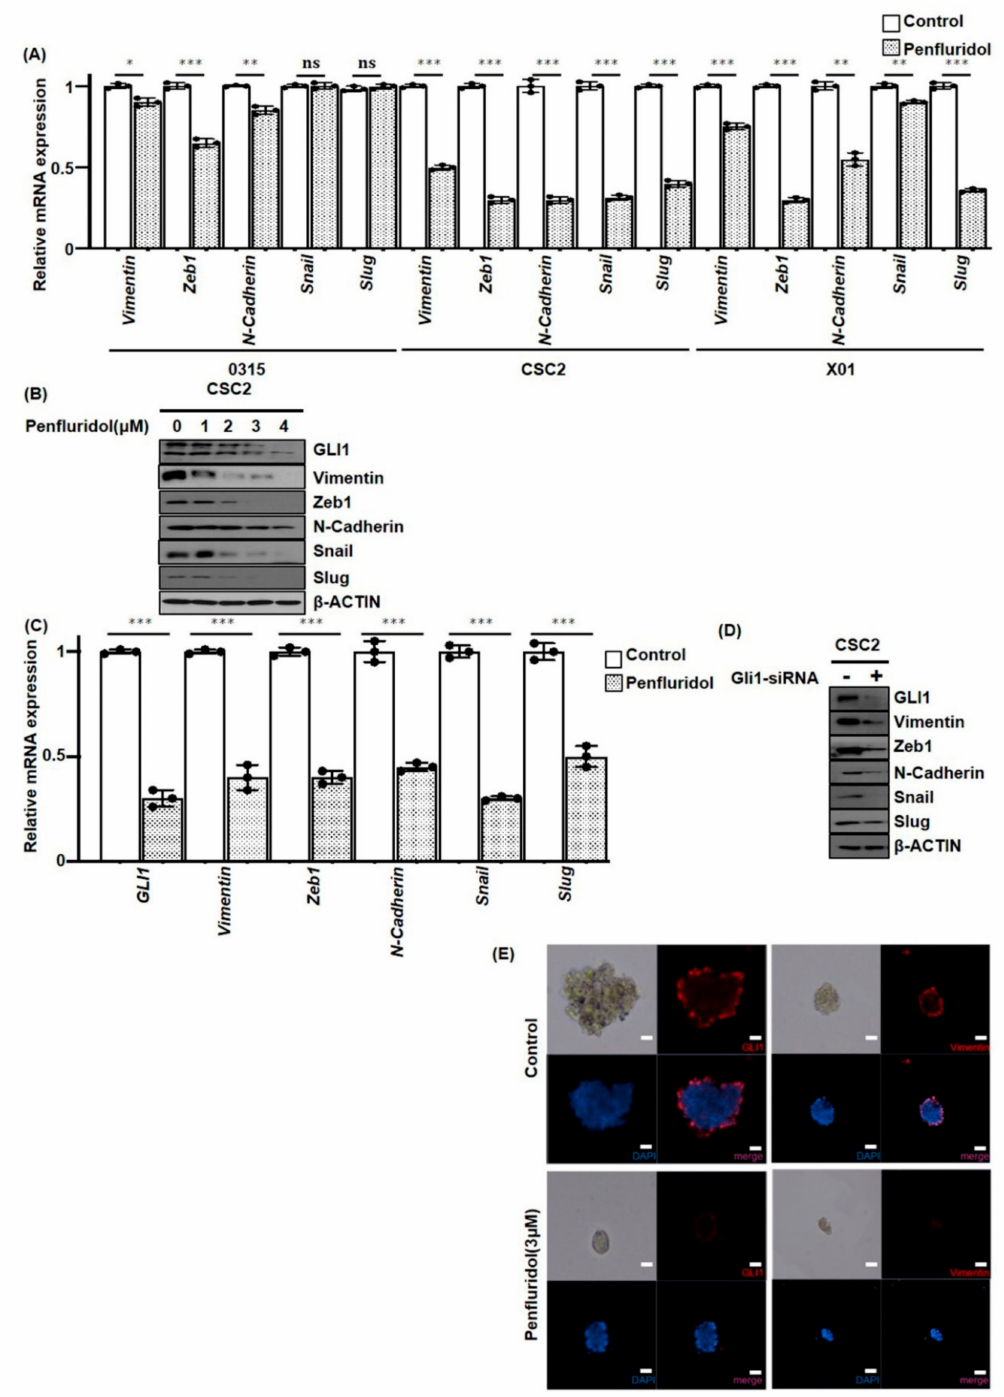
Figure 4. GLI1 inhibition by PFD suppresses EMT factors in GSCs. ( A ) RT-qPCR for vimentin, ZEB1, N-cadherin, Snail, and Slug at 48 h after 2 µ M PFD treatment, and ( B ) Western blotting analyses for GLI1, vimentin, ZEB1, N-cadherin, Snail, and Slug at di ff erent concentrations of PFD. Loading control used was GAPDH or β -actin. Data are presented as the mean ± SD of triplicate qPCR assays (ns, no significance; * p < 0.1, ** p < 0.01, *** p < 0.001, when compared with no treatment). ( C , D ) CSC2 cells were transduced with GLI1 siRNA, and examined by RT-qPCR and western blot analyses. Data are presented as the mean ± SD of triplicate qPCR assays (*** p < 0.001). ( E ) Immunocytochemistry for GLI1 and vimentin in CSC2 cells with 3 µ M PFD treatment at 48 h (blue, nucleus; red, vimentin and GLI1, Scale bar: 100 µ